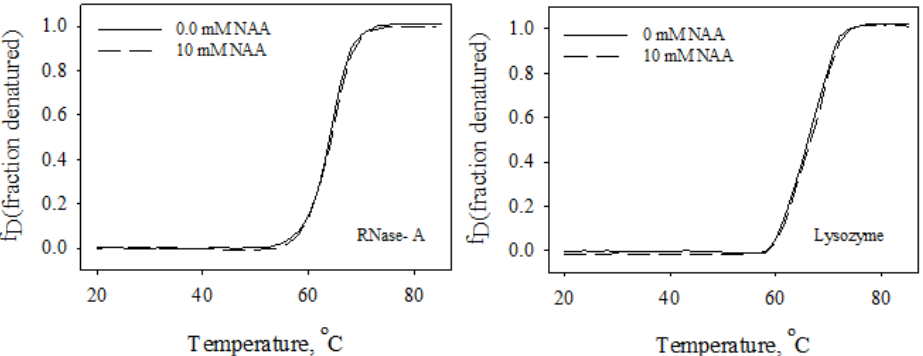
Figure 6. Thermal denaturation profiles of RNase-A and lysozyme at pH 7.0 in the presence of a physiological concentration of NAA.